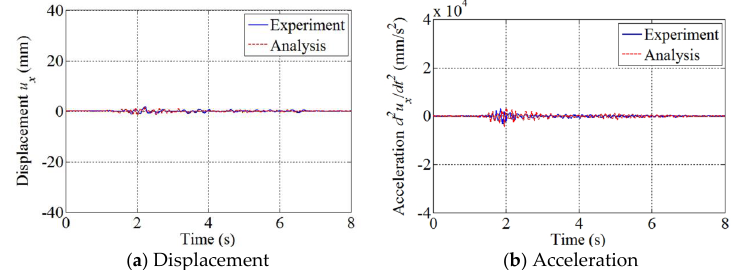
Figure 28. Numerical and experimental responses in the x direction due to the scaled Northridge aftershock of Run 21; responses sampled at point A on the third floor.